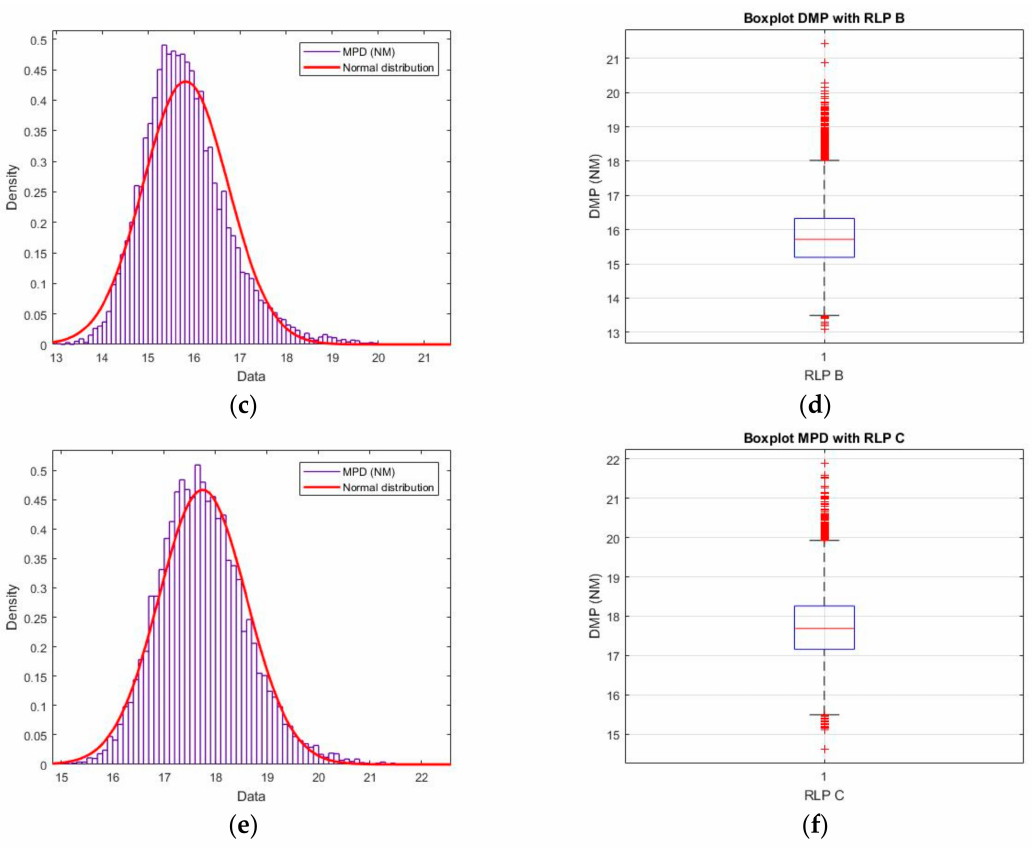
Figure 5. Results of Monte Carlo simulation for a ROC of 2000 ft / min and varying RLP. The charts on the left-hand side ( a , c , e ) show the normal distributions for each experiment. The charts on the right-hand side ( b , d , f ) give the corresponding boxplots.